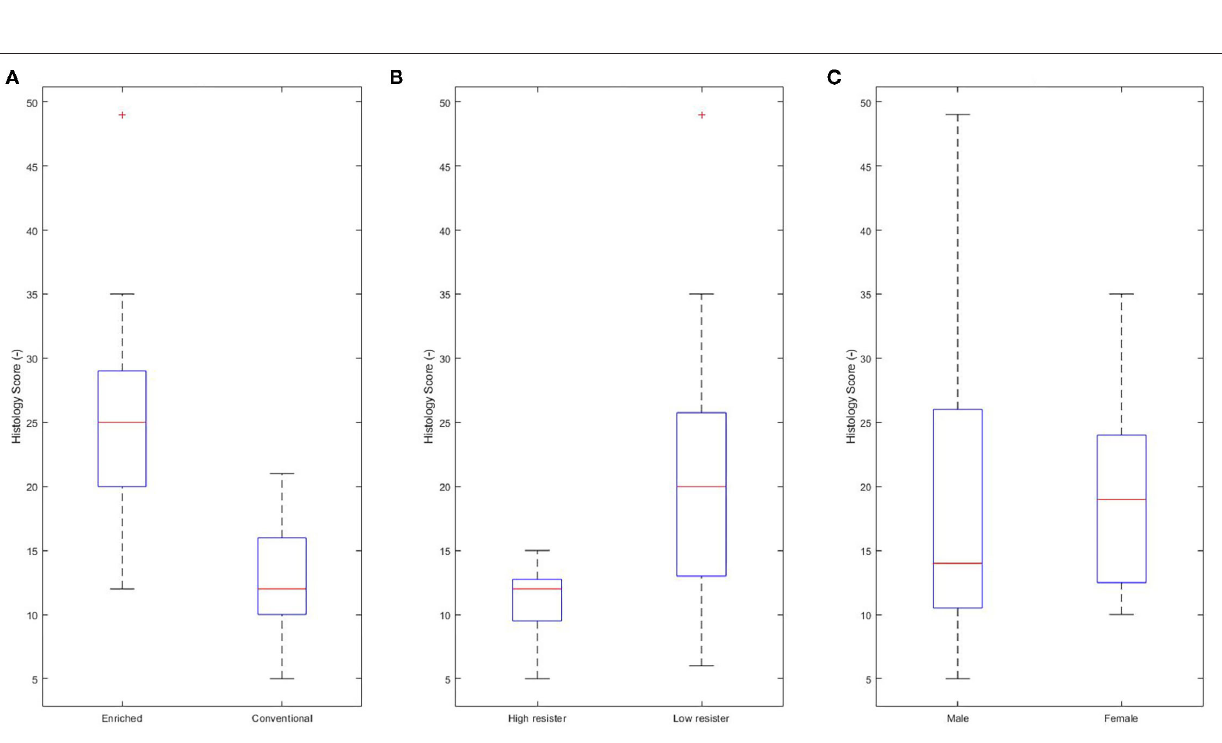
Frontiers in Veterinary Science |